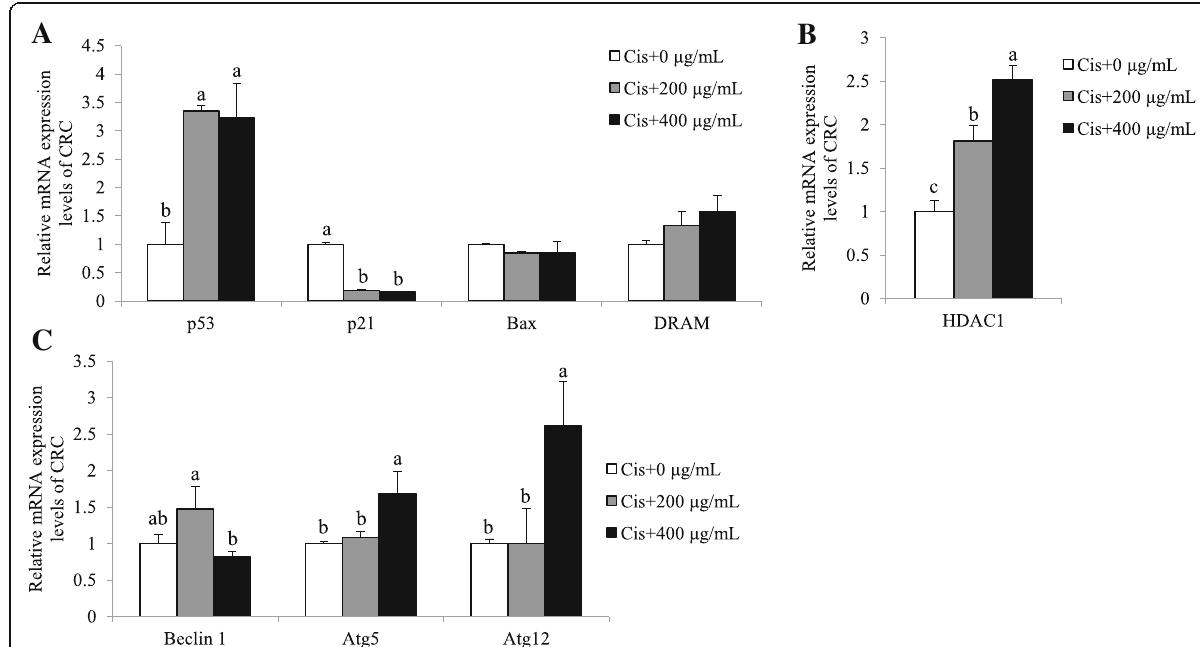
Fig. 7 Combination effects of SbE and cisplatin on mRNA expression levels of p53 , p21 , Bax , DRAM , Beclin 1 , Atg5 , and Atg12 in CRC. After cells were exposed 200 ~ 400 μ g/mL of SbE and 30 μ M of cisplatin for 24 h, mRNA expression levels of ( a ) p53 , p21 , Bax , DRAM , ( b ) HDAC1 , ( c ) Beclin 1 , Atg5 , and Atg12 in CRC were quantified by qPCR. All mRNA expression levels were normalized against TBP . Each value is the mean ± SD. p < 0.05 was taken to define statistical significance. One-way ANOVA followed by Duncan post hoc test. Cis; 30 μ M of